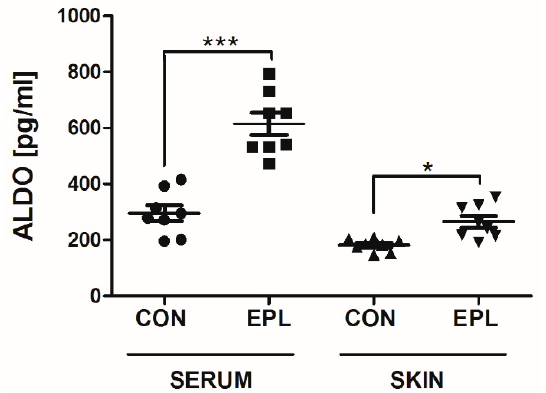
Figure 8. Changes in the serum and skin ALDO concentrations after chronic EPL administration. n = 8; n for each group is the number of skin samples, not the number of animals; 32 rats were used in this experiment; data are presented as mean ± SEM and individual values; ALDO—aldosterone; CON—5% gum arabic solution; EPL—eplerenone; * p < 0.05; *** p < 0.001.